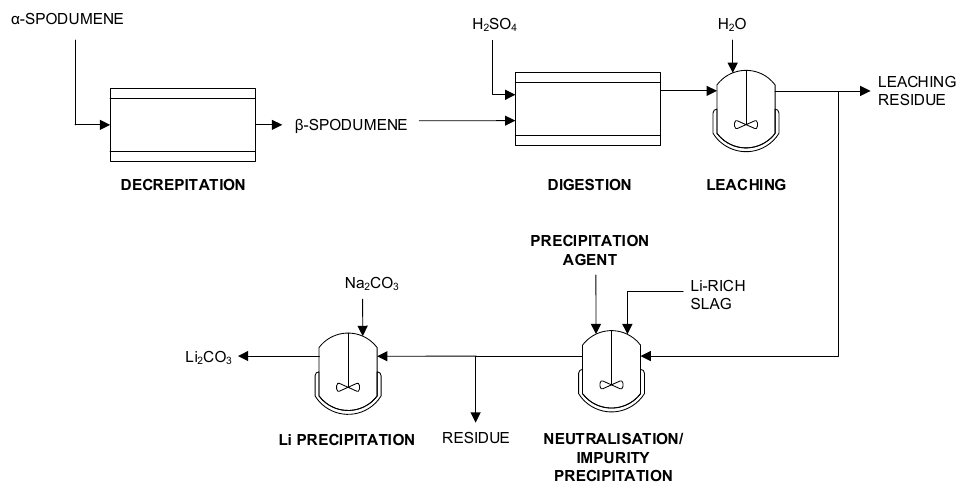
Figure 8. Simplified flowsheet of spodumene processing with partial replacement of Ca-based neutralizing agent based on [59,65].